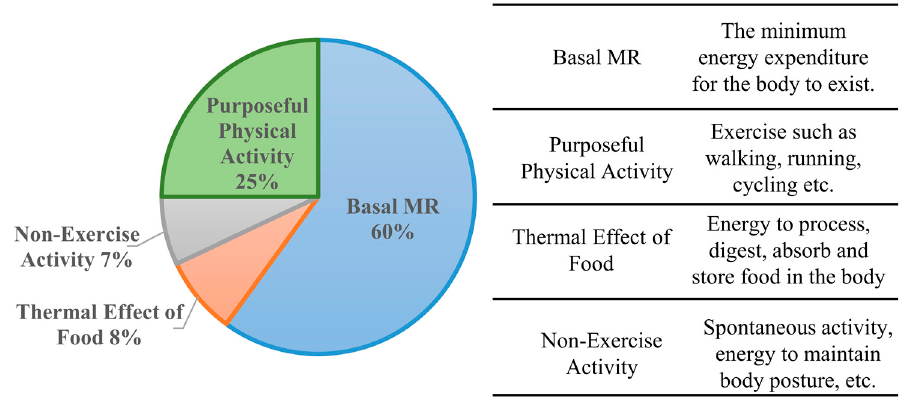
Figure 1. Components of EE [100].